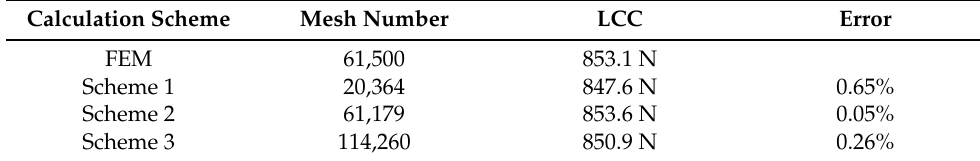
Table 2. Mesh independence